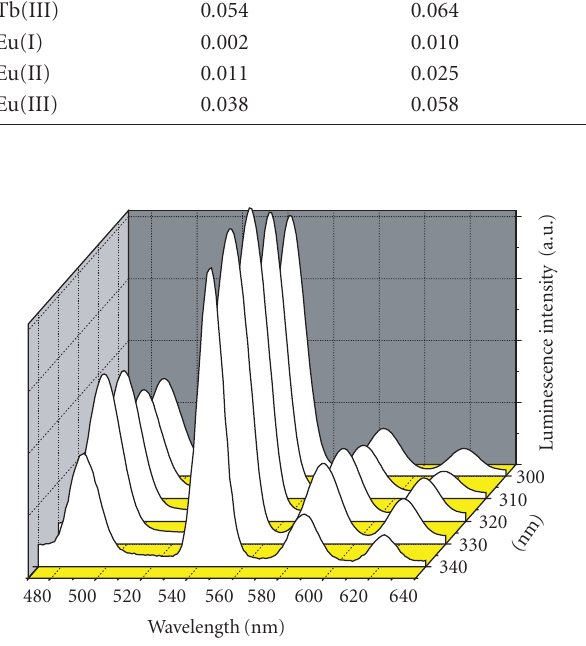
Figure 6: 3D view of the emission spectra of Tb 3+ ion in Tb-(III) complex at di ff erent excitation wavelengths in DMSO.